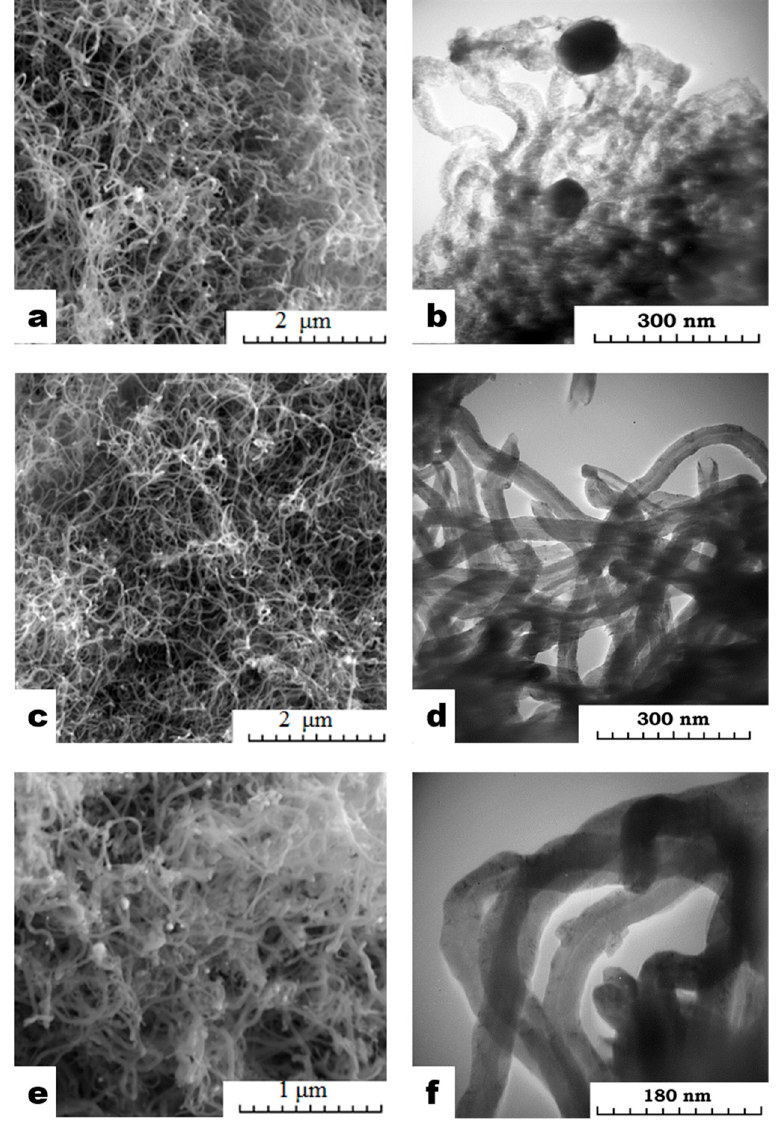
Figure 4. Morphology and structure of MWCNTs synthesized on ( a , b )—Ni/ 0.3 MgO, ( c , d )—Ni/ 0.5 MgO, and ( e , f )—Ni/ 0.16 MgO catalysts.